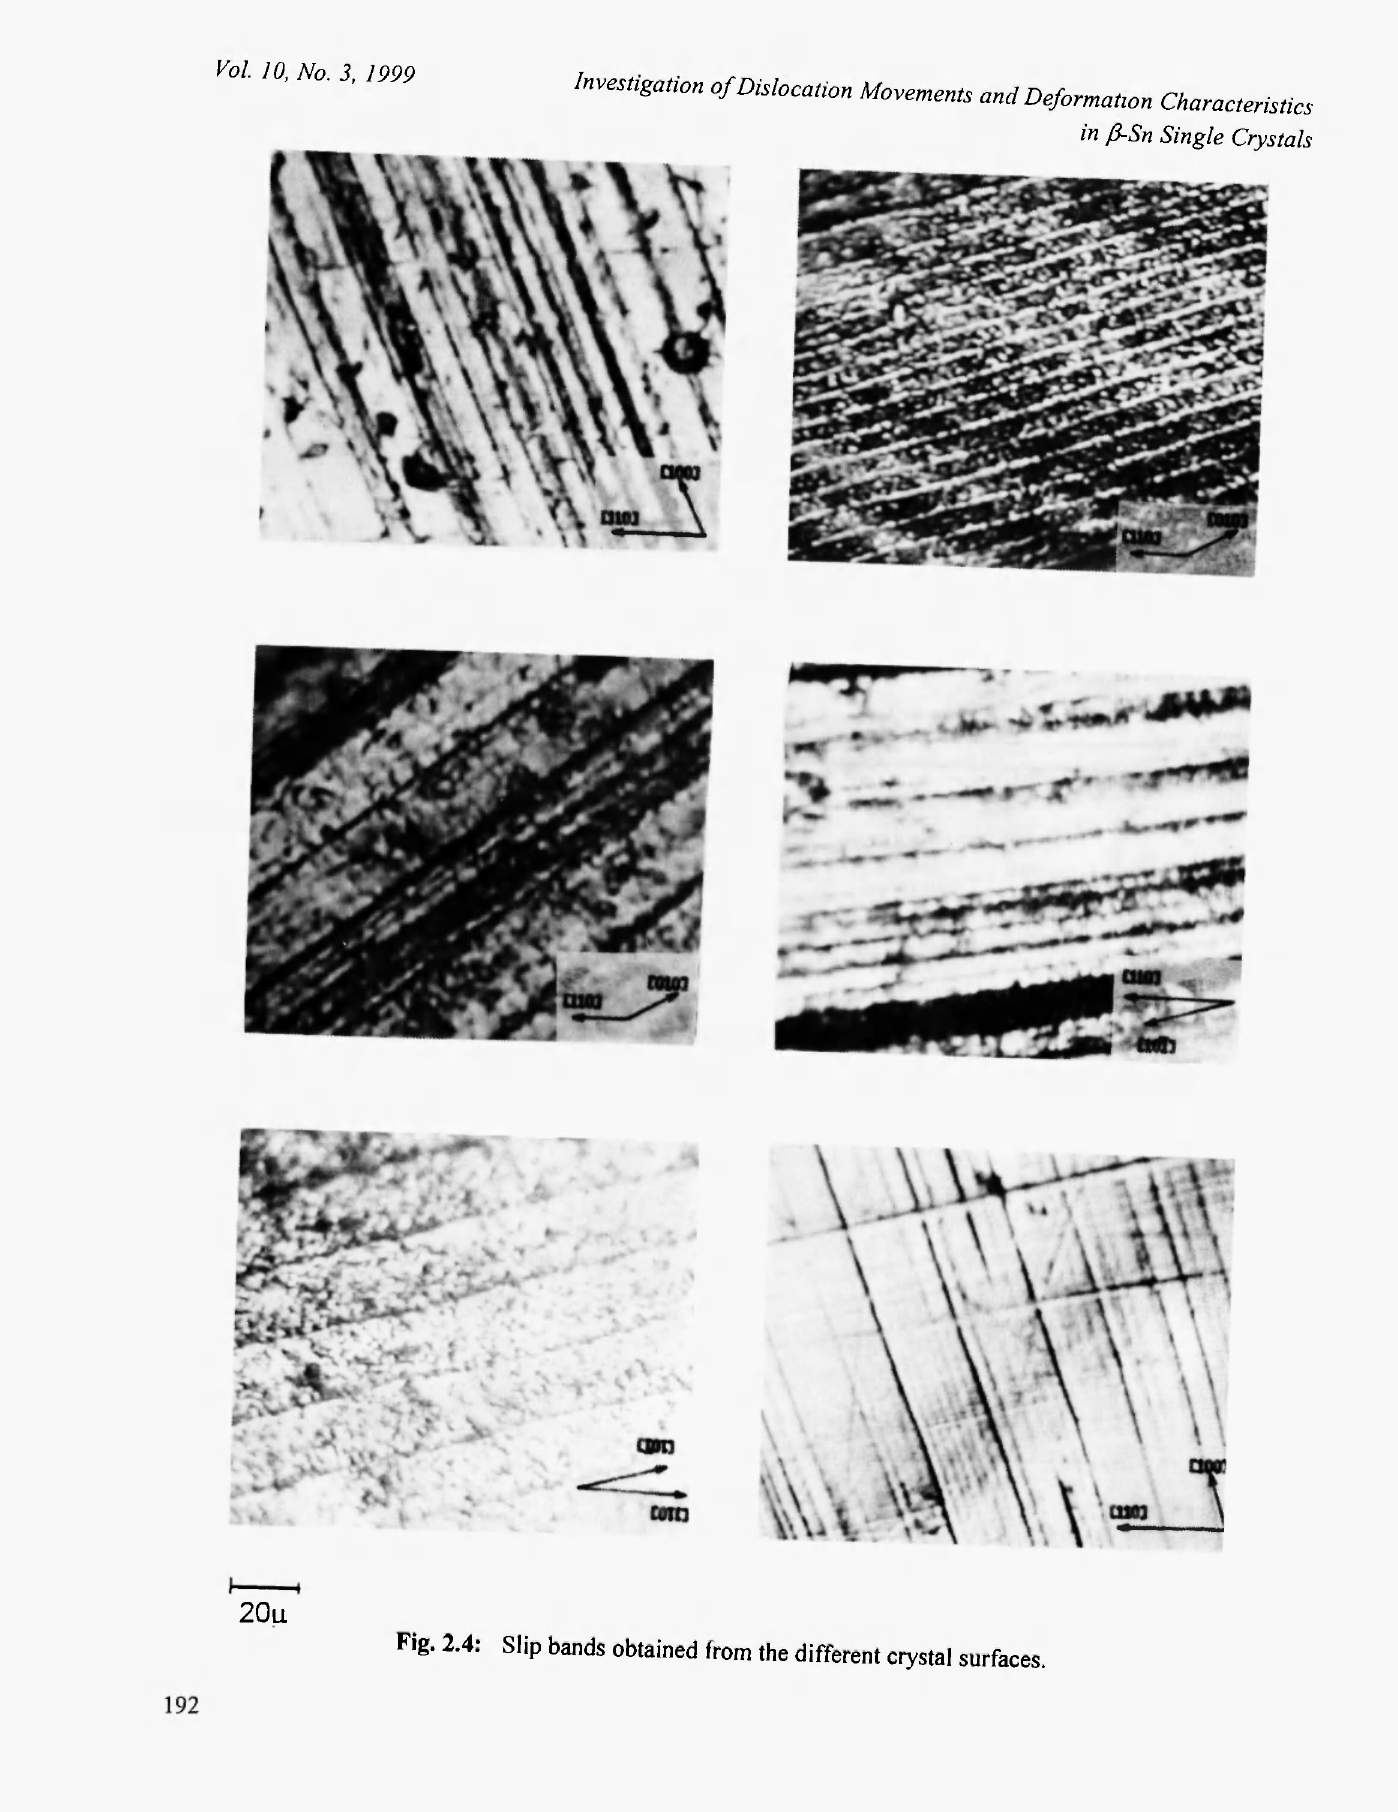
Fig. 2.4: Slip bands obtained from the different crystal